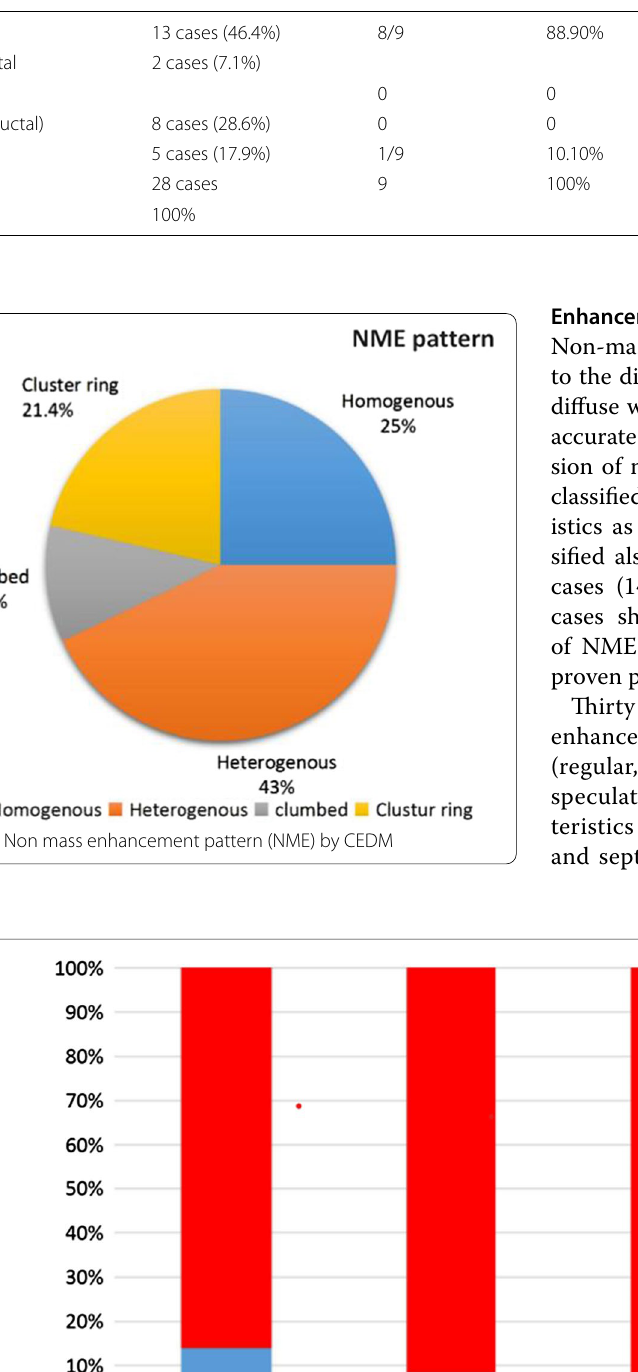
Table 3 Correlation between distribution of non-mass enhancement (NME) by CEDM and final pathological findings Distribution